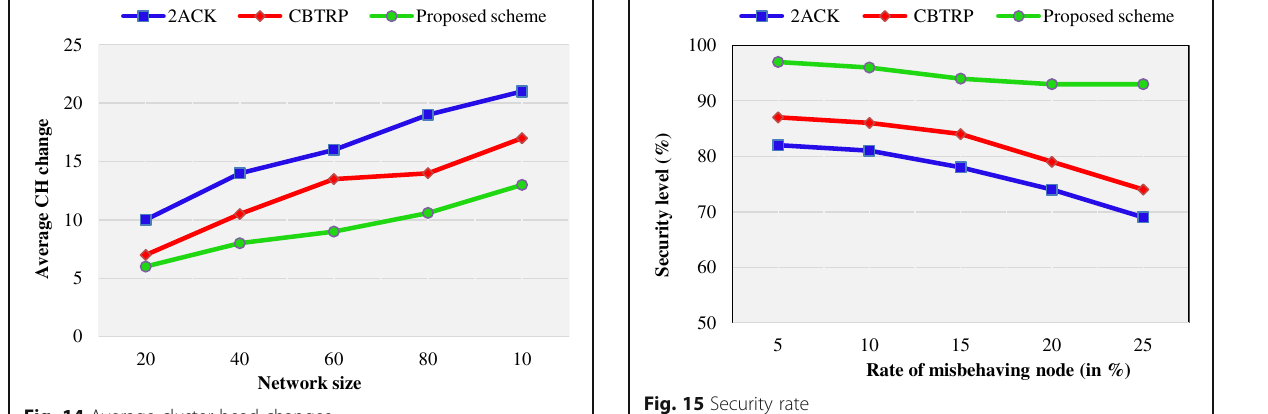
Figure 15: security level demonstrates the level of secu- uring the security strength of the proposed